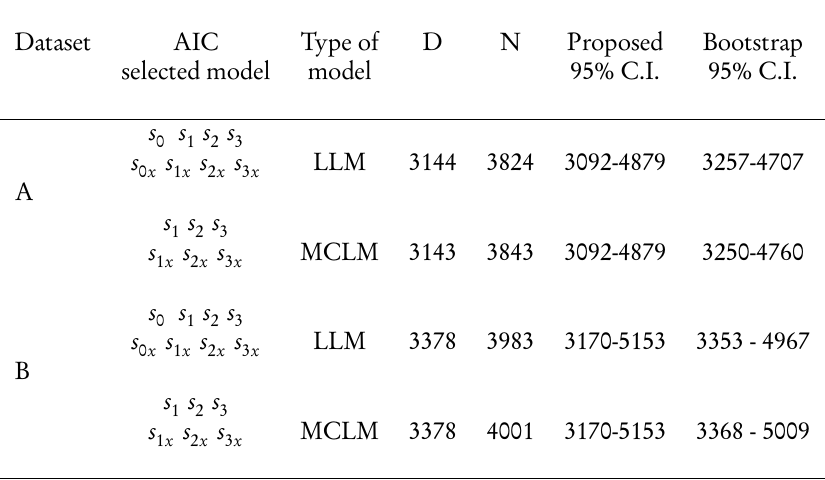
Mean deviance (D), analytically estimated population size (N) and 95% confidence interval (C.I.), bootstrap non-parametric 95% confidence interval (C.I.) obtained on simulated datasets for the proposed Poisson LLM and